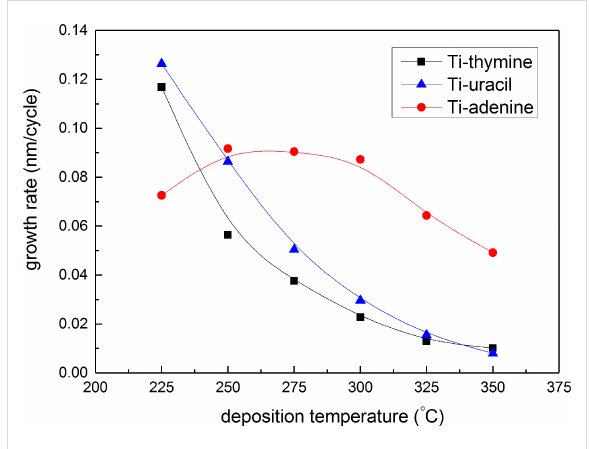
Figure 4: Film growth as a function of deposition temperature for TTIP and thymine (black squares), adenine (red circles), and uracil (blue tri-